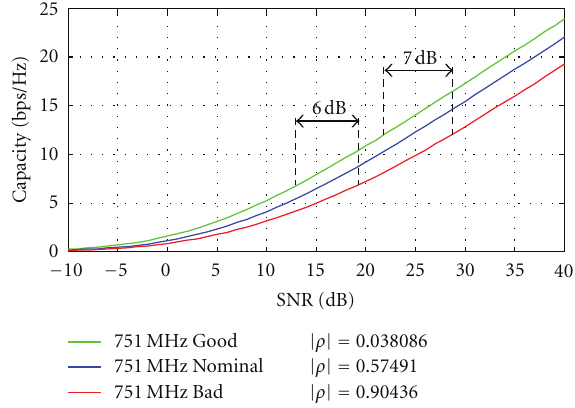
Figure 17: Capacity curves as functions of SNR for the “good,” “nominal,” and “bad” reference antennas in an isotropic envi- ronment. To achieve a capacity of 7 bps/Hz, the three reference antennas require very di ff erent SNR values: the bad reference antenna requires an SNR of 19dB, whereas the good reference antenna requires only an SNR of 13 dB. The di ff erence in SNR between good and bad reference antennas is in this case 6 dB. Similarly, to achieve a capacity of 12.5 bps/Hz, the di ff erence in SNR between good and bad reference antennas is 7